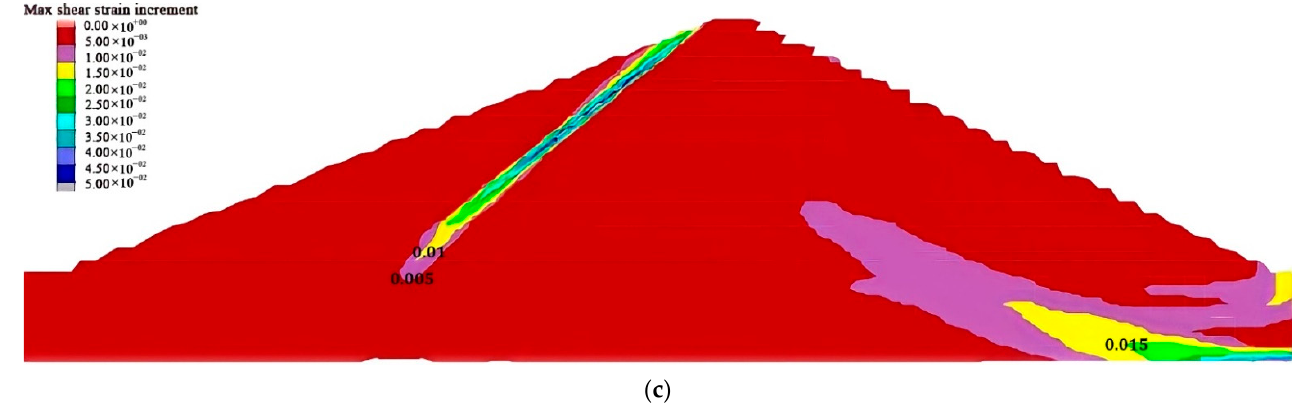
Figure 11. Shear strain contour during earthquake loading: ( a ) 90° angled core, ( b ) 60° angled core and ( c ) 45° angled core.